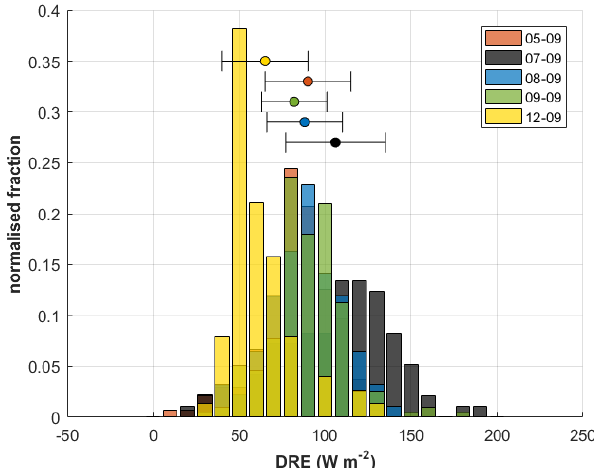
Figure 12. DRE histogram retrieved from OSIRIS’s aerosol and cloud retrievals for the five selected flights. Circles and error bars correspond to mean DRE and calculated DRE uncertainties follow- ing the description in Appendix